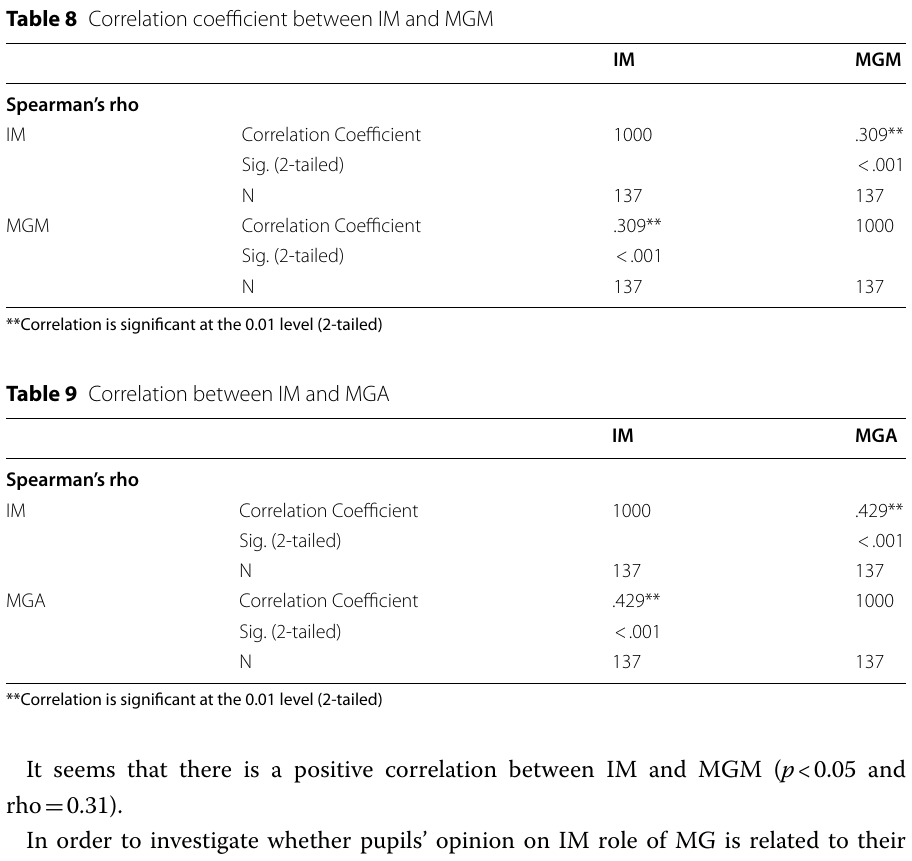
Table 8 Correlation coefficient between IM and MGM